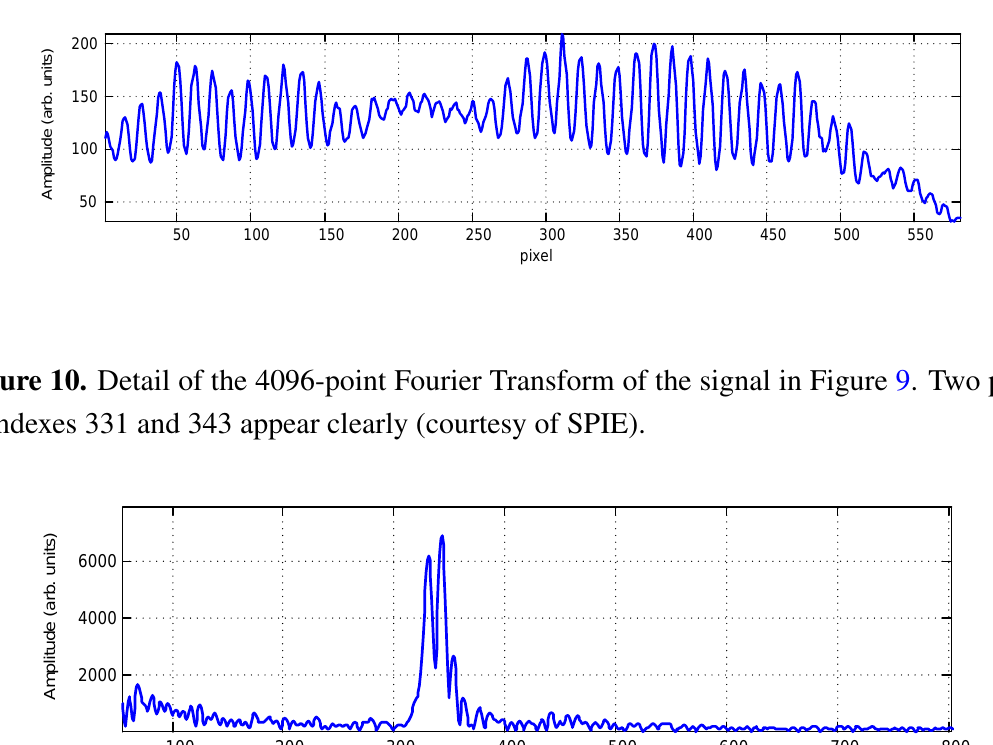
Figure 9. Obtained signal corresponding to a single column. A low-frequency beat phenomenon is observed (courtesy of SPIE).